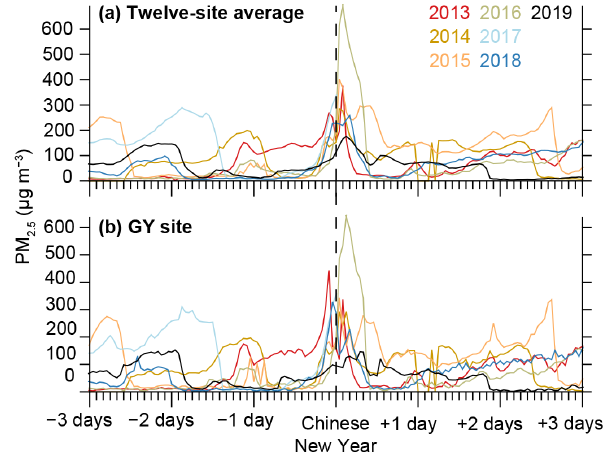
Figure 8. PM 2 . 5 averaged from 12 MEP sites in Beijing (a) and from only the Guangyuan (GY) site, which is the closest MEP mea- surement site to BUCT-AHL (b) , from 3d before through 3d after the 2013–2019 CNY. The highest peak of pollution during the CNY overnight was in 2016, and the lowest was in 2019.